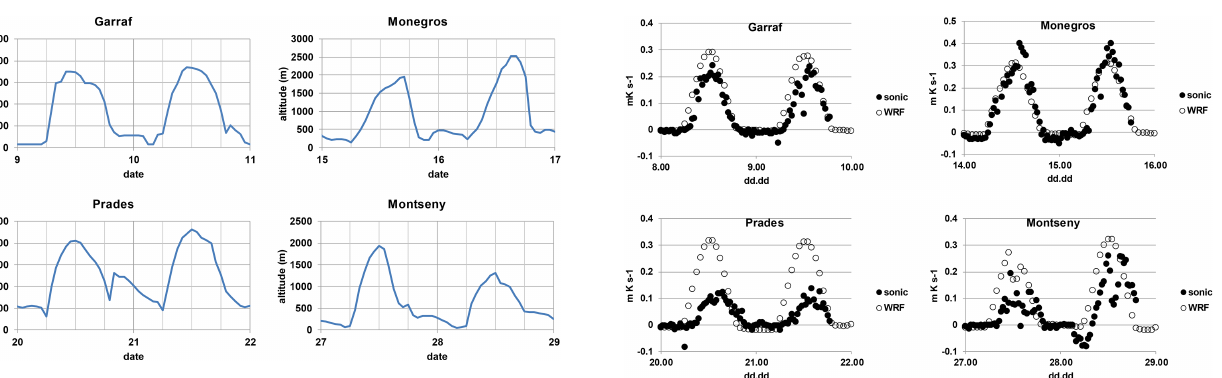
− 1 ) mea- sured at each site with that calculated by the WRF model. For Garraf and Monegros, the measurements were made above the low shrub vegetation; for Prades and Montseny, the flux was measured in a clearing below the canopy within a forest landscape. Agreement was very good where the measurement fetch was similar to the sur- rounding landscape (Garraf and